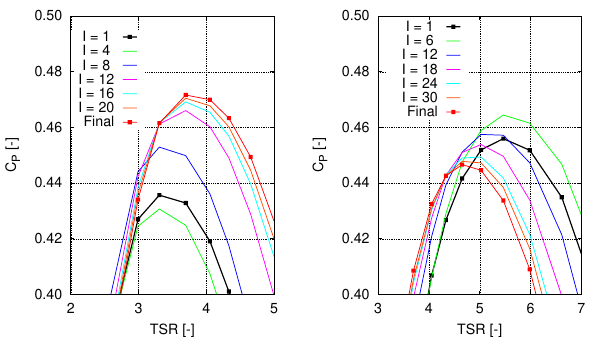
Fig. 14. Model turbine: convergence of power coefficient curves in the peak power region at λ des = 3 . 0 (left) and λ des = 5 . 0 (right). The condition (8) on thrust curve slope ∂C curve slope and then kept fixed for a number N